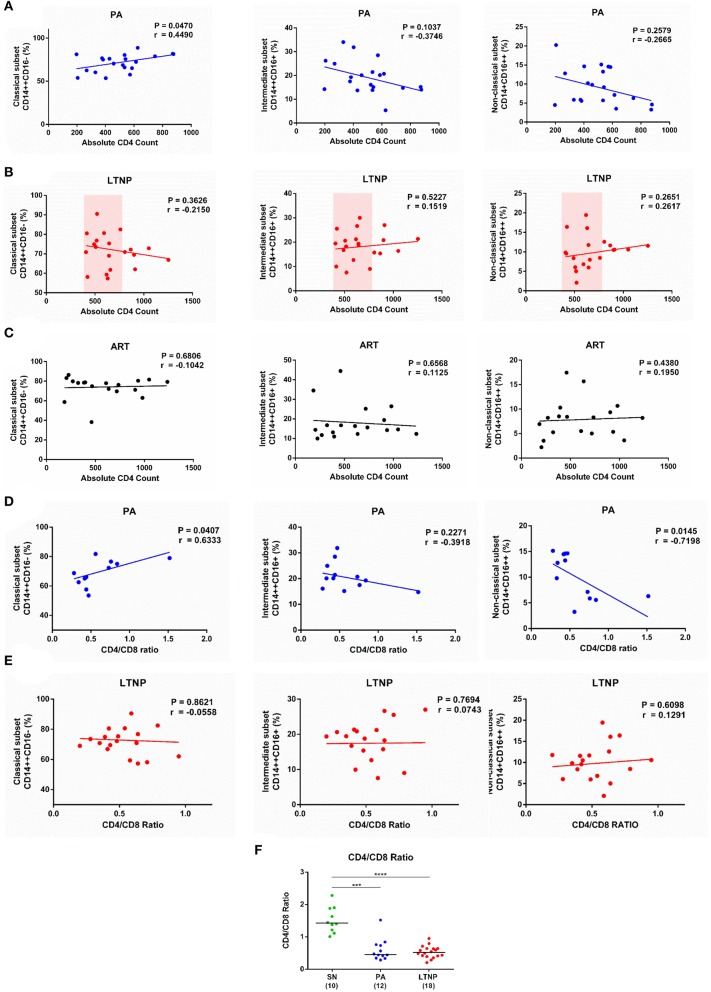
Association of monocyte subsets with CD4 count and CD4/CD8 Ratio. (A–C) Correlation analyses of monocyte subset frequencies with absolute CD4 count in the PA (n = 20), LTNP (n = 20), and ART (n = 18) groups, respectively. Note the clustering of absolute CD4 counts around the median value of 500 cells/μL in the LTNP group. (D,E) Correlation analyses of frequency of classical, intermediate and non-classical monocytes with CD4/CD8 ratio in PA (n = 12) and LTNP (n = 18) groups, respectively. Association between variables was evaluated by linear regression and Spearman correlation test was used to determine correlation co-efficient (r) and significance (P < 0.05). (F) Comparison of CD4/CD8 ratios of therapy-naïve groups (PA and LTNP) with seronegative (SN) controls. Statistical significance was estimated by Kruskal-Wallis ANOVA followed by Dunn's multiple comparison test; ***P < 0.001; ****P < 0.0001.